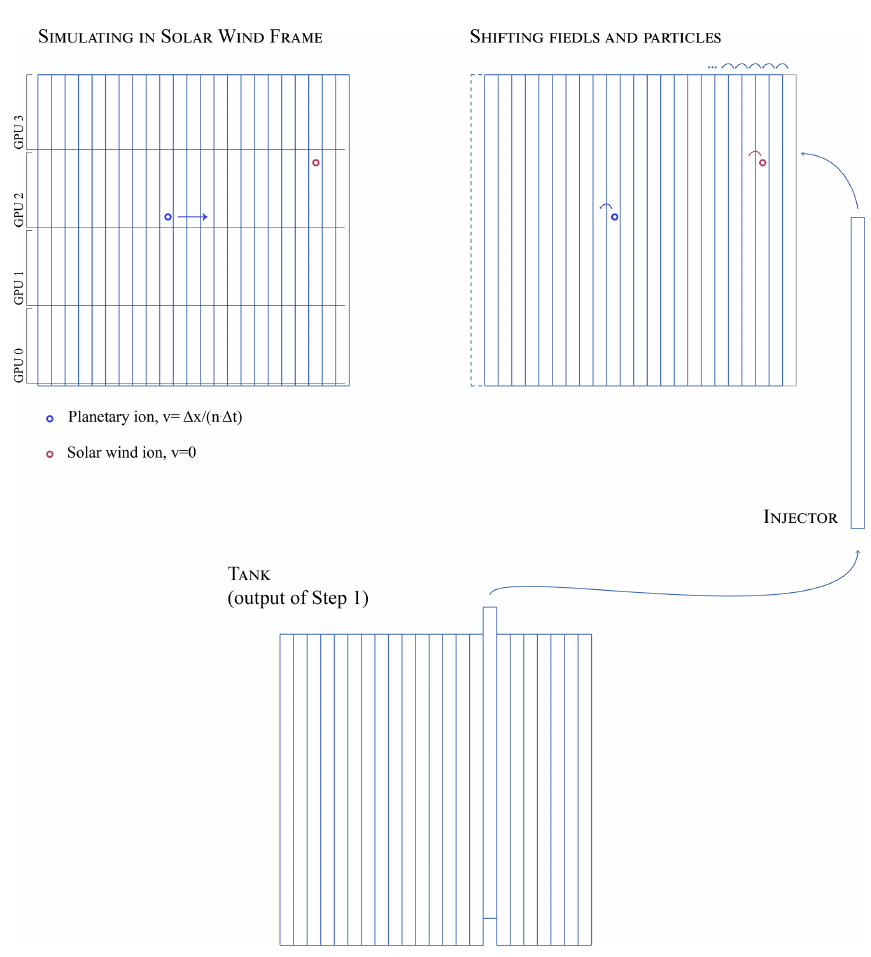
Figure 6. Injection algorithm for simulating a moving object within the simulation